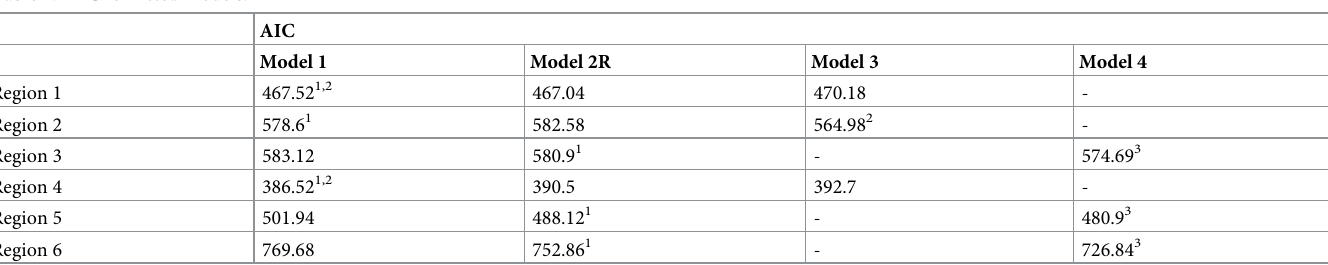
Table 1. AIC for fitted